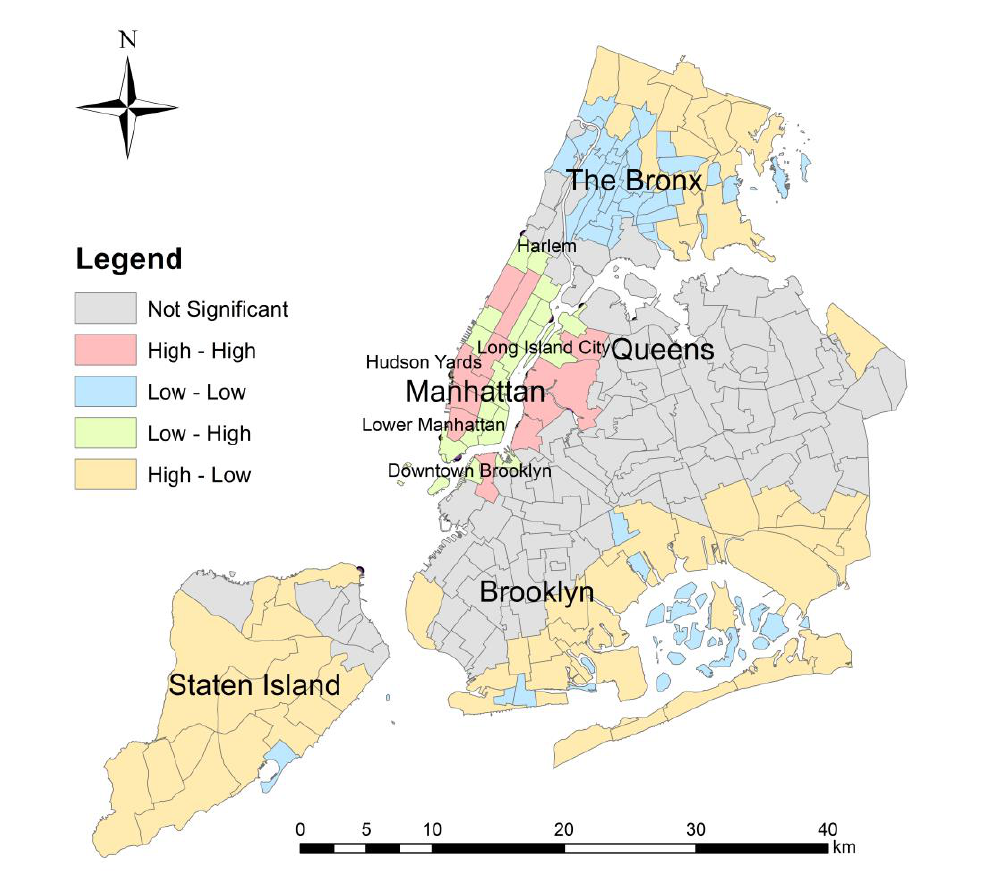
Figure 4. Clusters and outliers of male and female users’ activity counts in